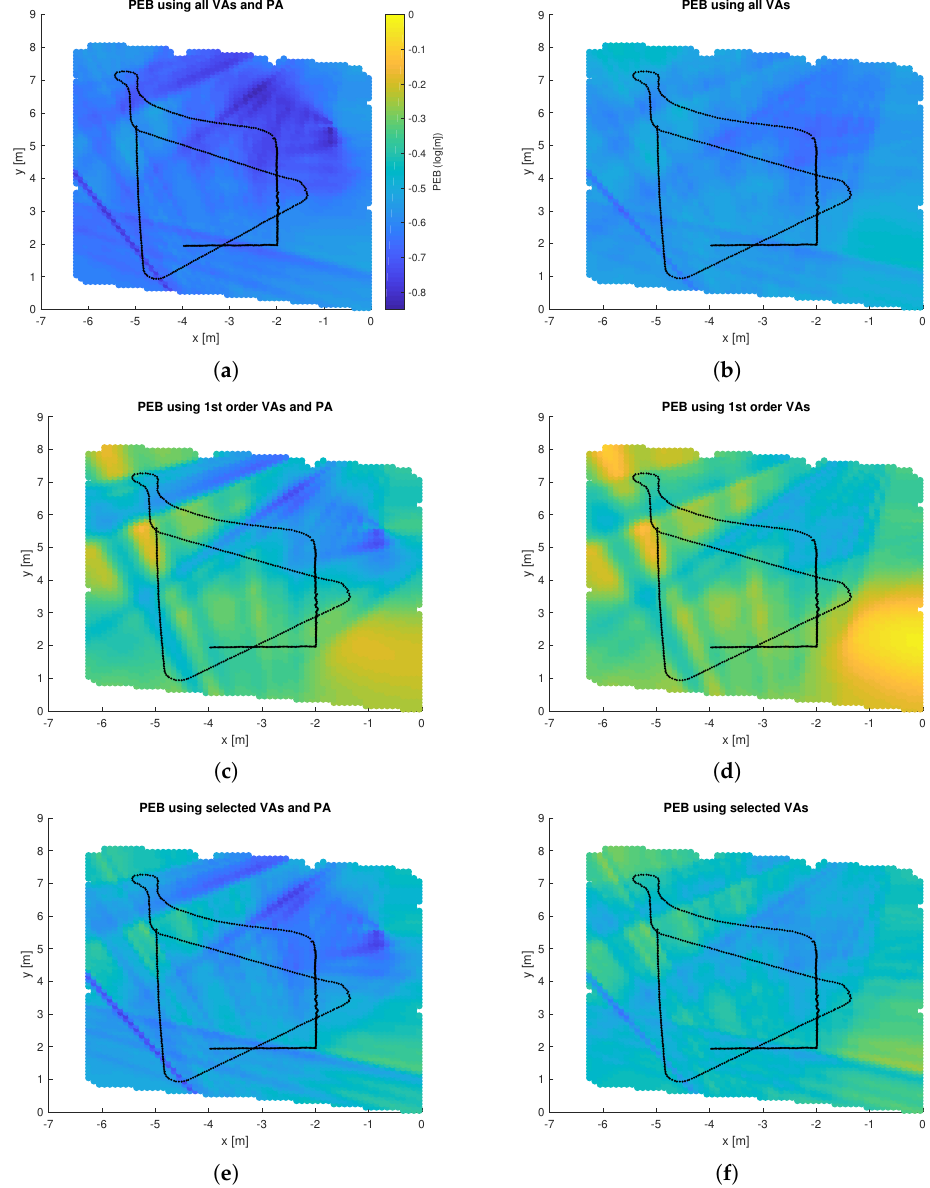
Figure 9. GPR-predicted PEB considering information from SMCs corresponding to: ( a ) all VAs and the PA, ( b ) all 1st and 2nd-order VAs, ( c ) 1st-order VAs and the PA, ( d ) all 1st-order VAs, ( e ) selected VAs and the LOS, ( f ) selected